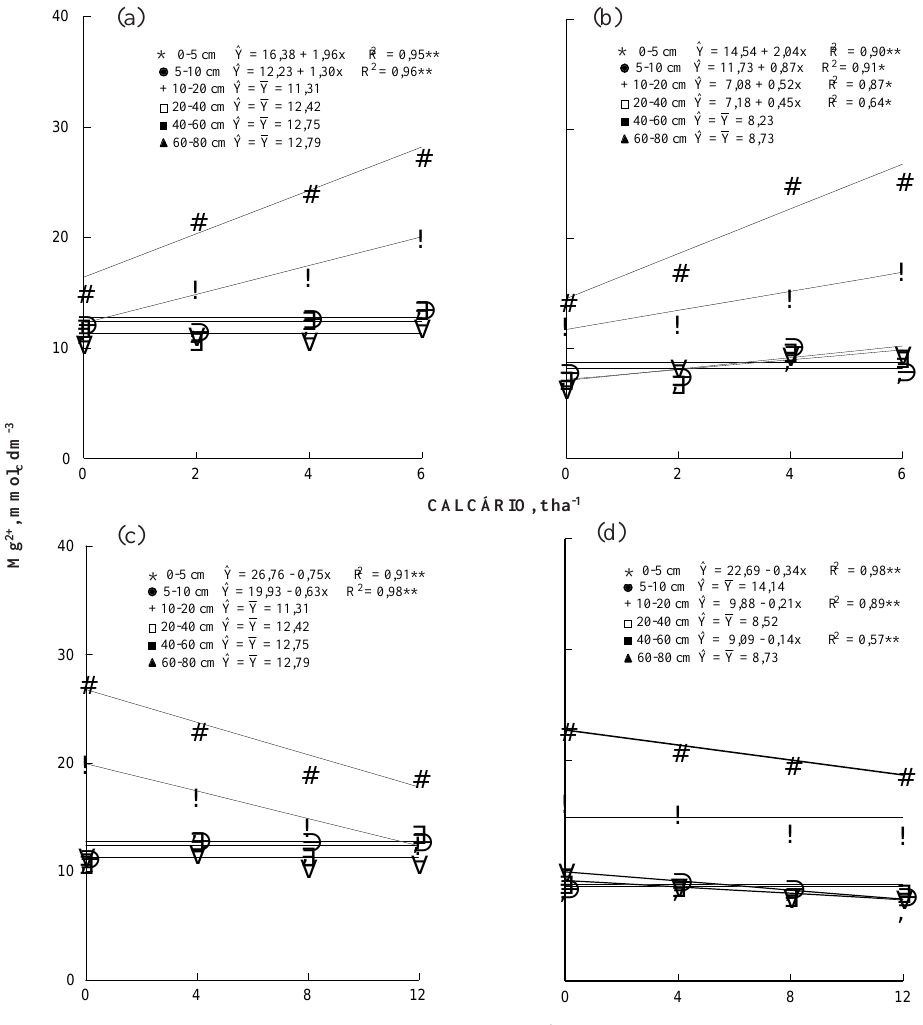
Figura 4. Efeito de doses de calcário, após 18(a) e 40(b) meses, e de gesso, após 14(c) e 36(d) meses, nos